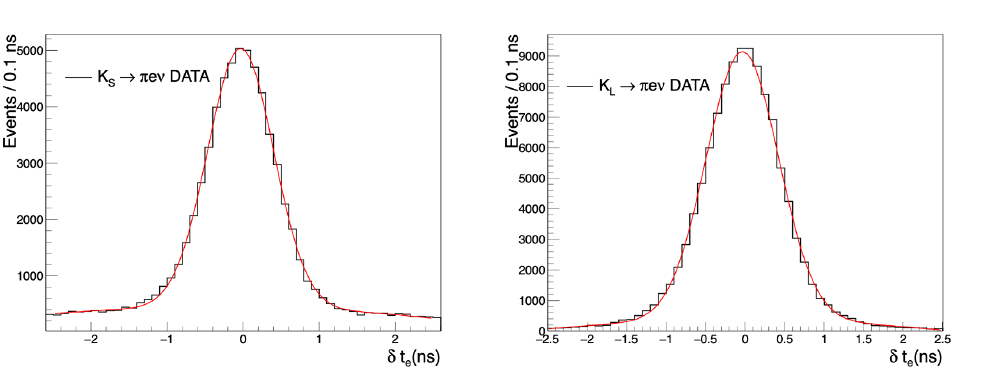
Figure 8 . Comparison of the δt e distribution for the signal (left) and for the K L → πeν control sample (right).